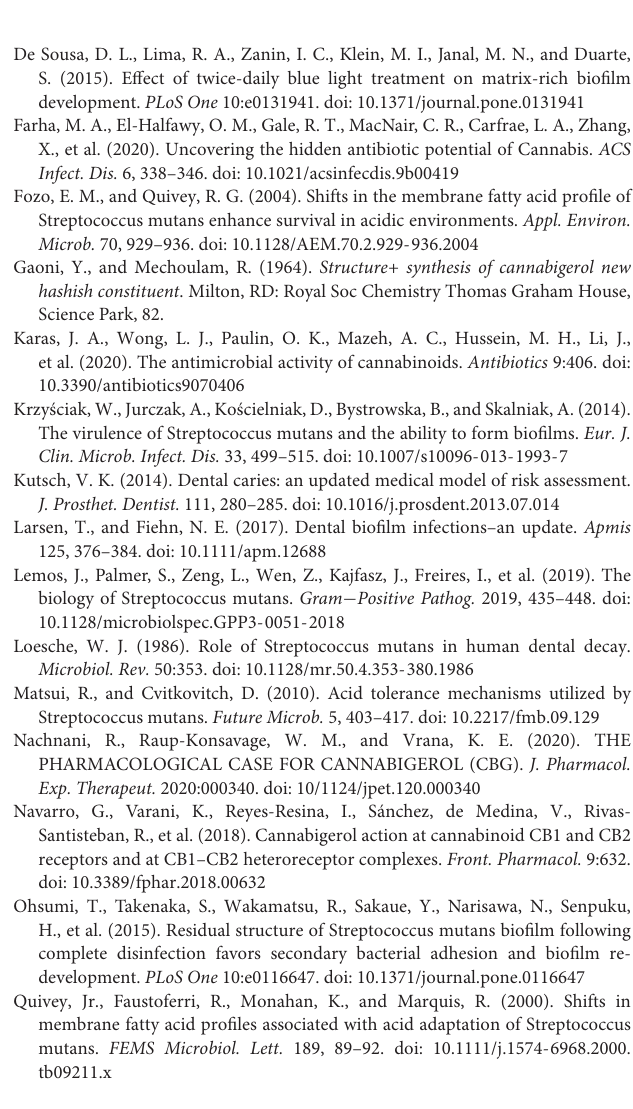
Supplementary Figure 1 | Drop method to detect bacterial growth of S. mutans on BHI-agar plates after treatment with different concentrations of CBG (0–10 µ g/ml) at various time points. At the end of incubation, 10 µ l of each sample was applied in triplicates on BHI agar plates and incubated overnight at 37 ◦ C. Supplementary Figure 2 | Flow cytometry dot plots of DiOC2(3)-stained S. mutans that have been exposed to different CBG concentrations (0–10 µ l/ml) for 30 min. The Y -axis shows the red fluorescence, while the X -axis shows the green